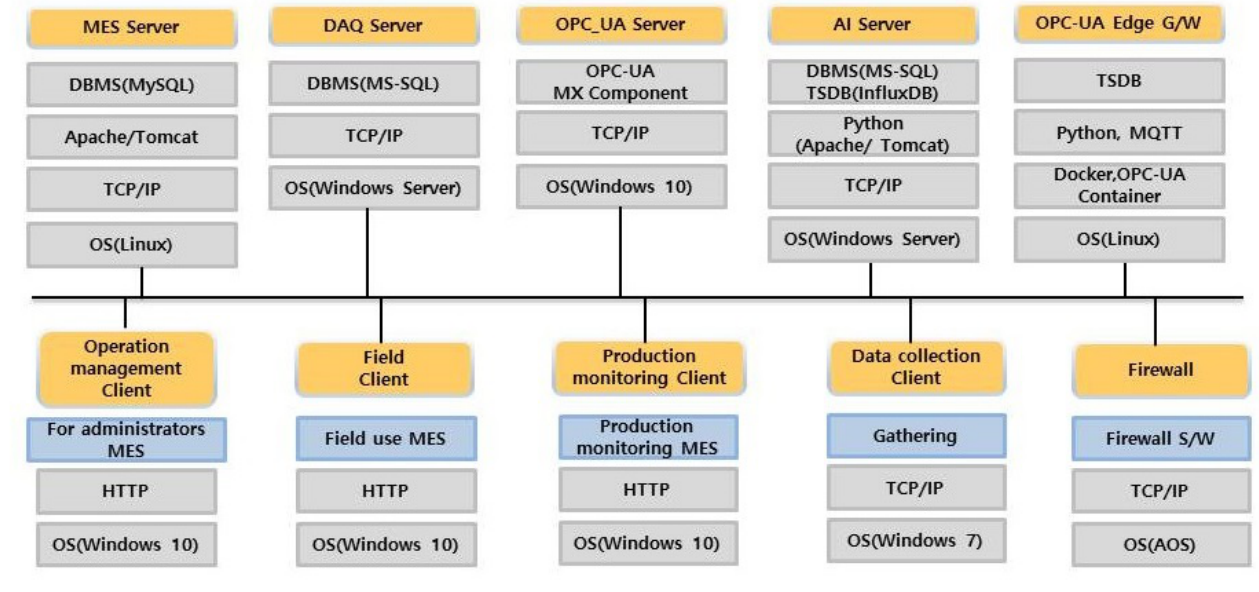
Figure 10. The software configuration.